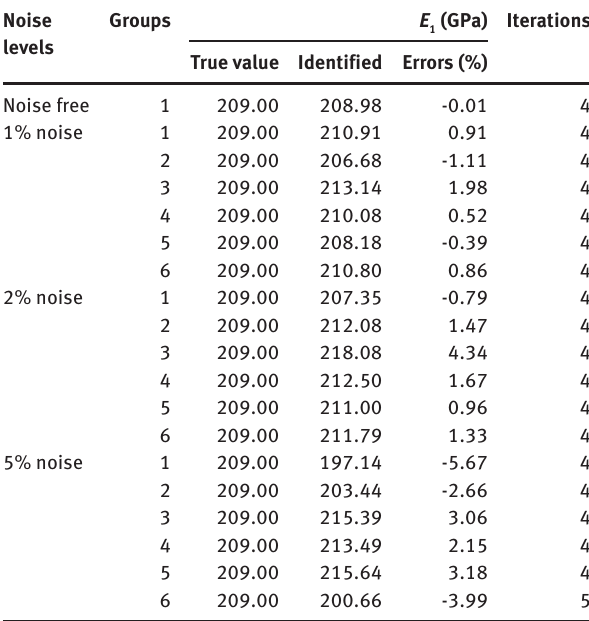
Table 6: Identified parameters of a square FGM plane structure with exponential material variation (case 2: initial value E